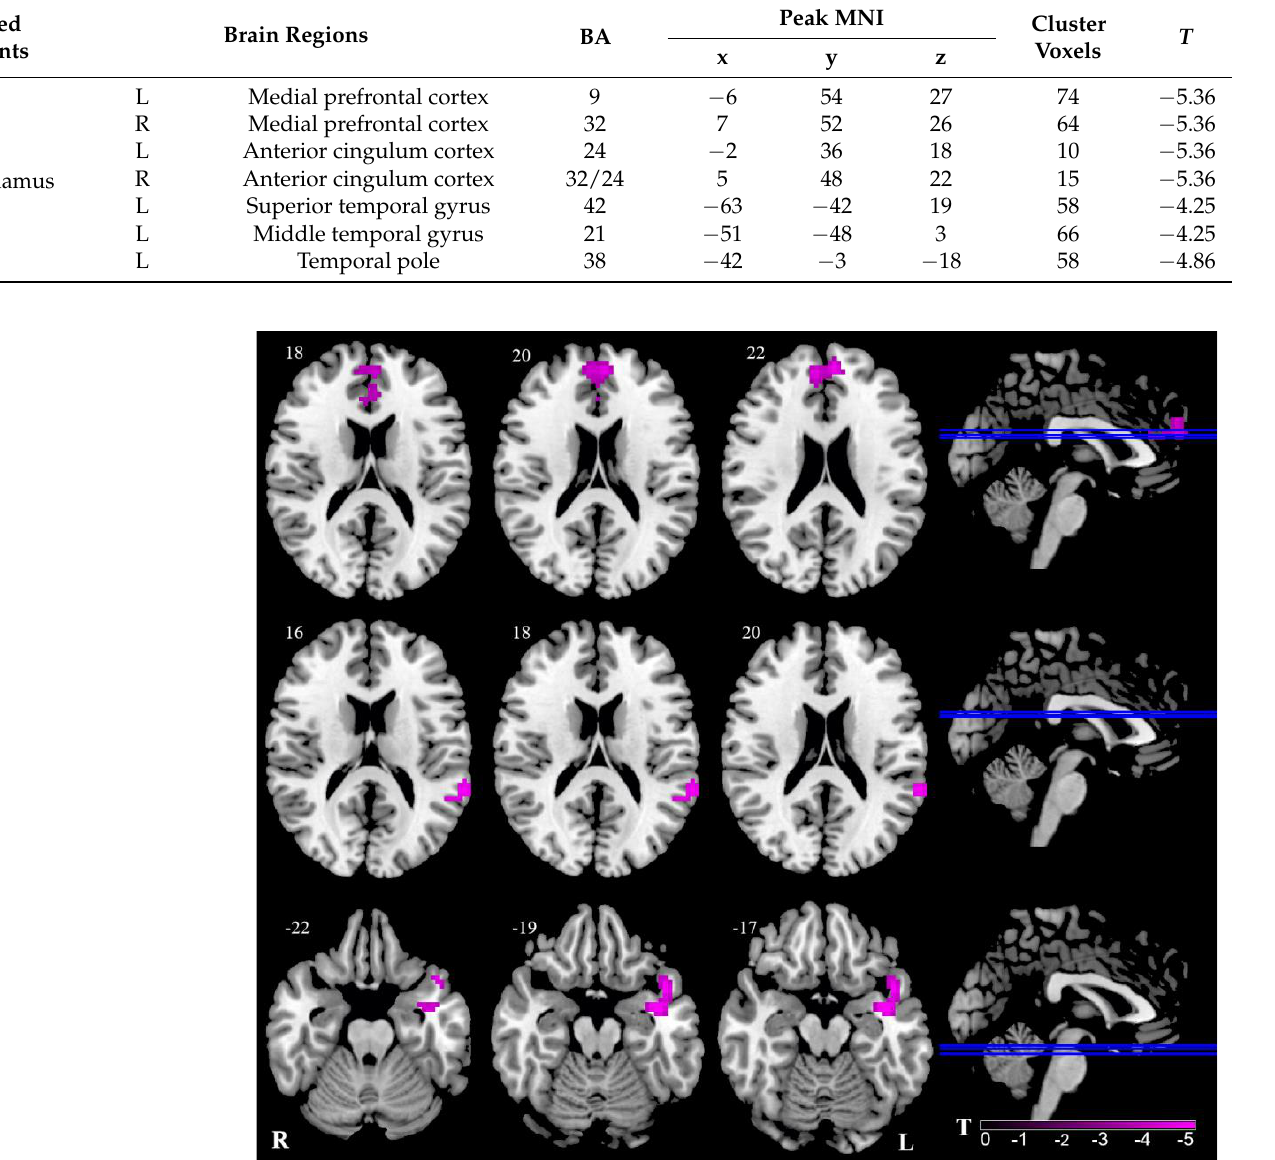
Table 3. Abnormal FC of left thalamus in VM patients compared with HC.